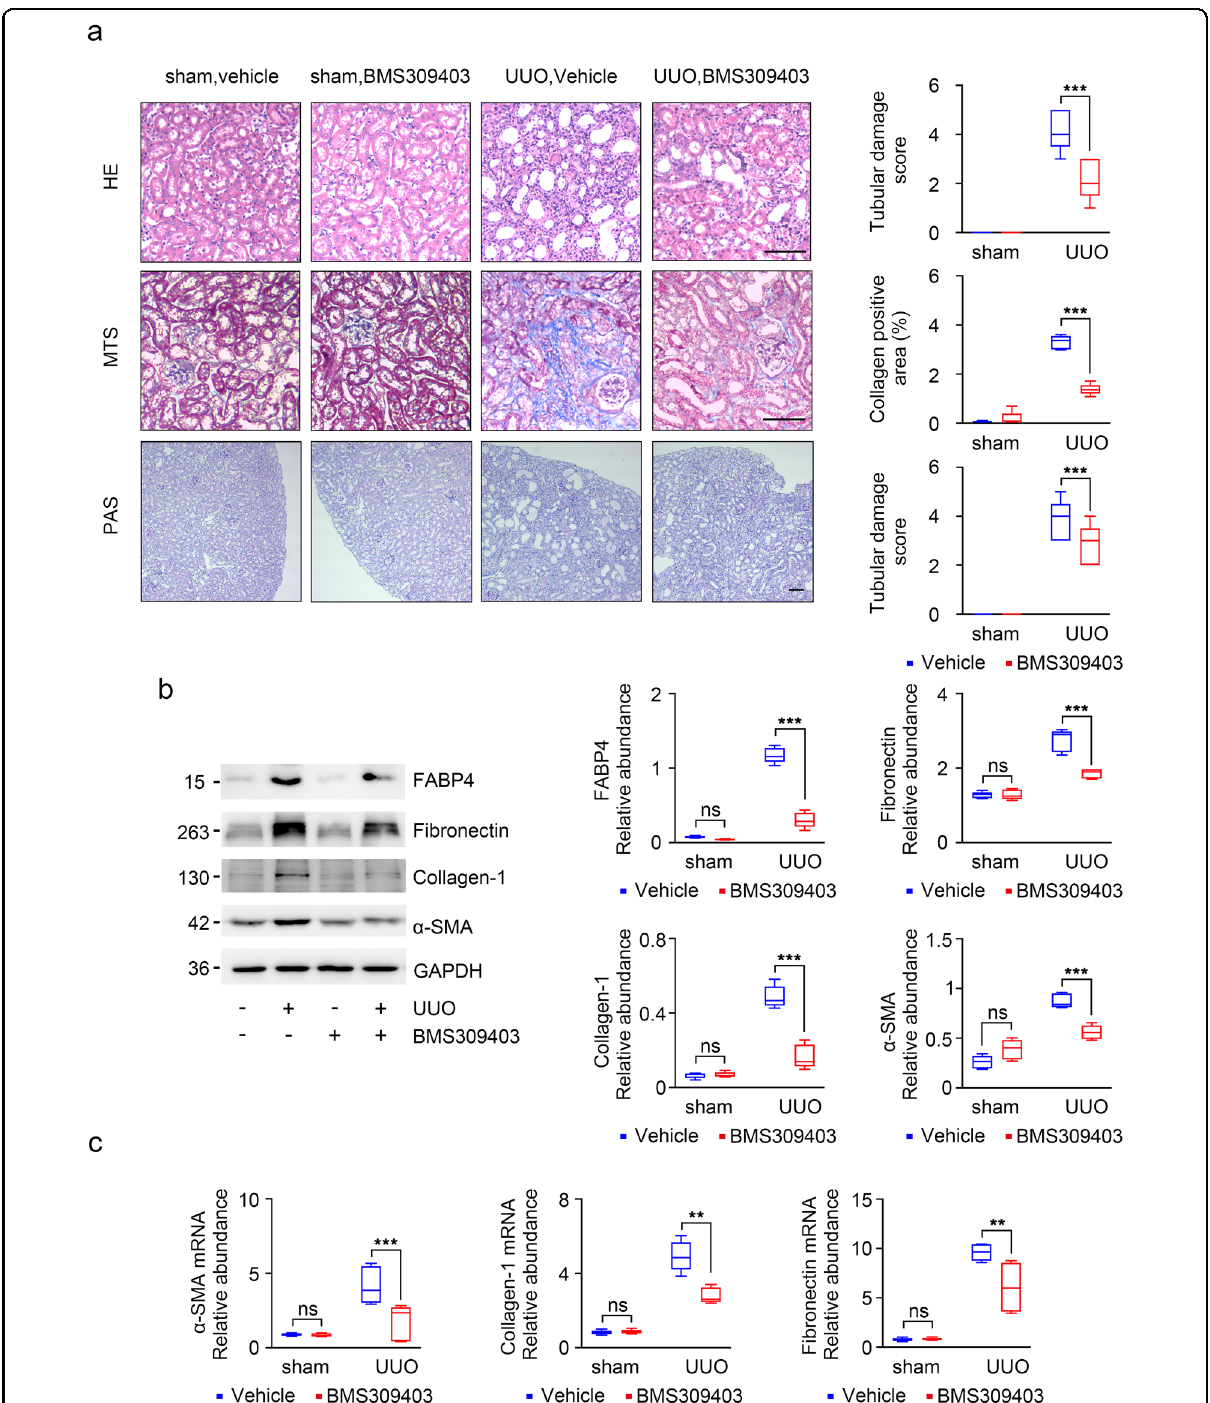
Fig. 5 BMS309403 improved kidney lesion by UUO. a Staining with HE, PAS, and MTS of kidney sections from obstructed (UUO) or sham-operated kidneys (control). Animals received BMS309403 (40 mg/kg for 8 days) or vehicle as indicated. n = 6 per group. b Western blot of whole-kidney lysates for FABP4, fi bronectin, collagen-I, and α -SMA expression. GAPDH sets as loading control. c Fibronectin, collagen-I, and α -SMA mRNA expression by RT-qPCR. Schematic representation of quantitative data of indicated proteins. The transcripts normalized to Gapdh. Representative images from three independent experiments are shown above. ** P < 0.01, *** P < 0.001, ns means no statistical signi fi cance. Scale bars: 25 μ